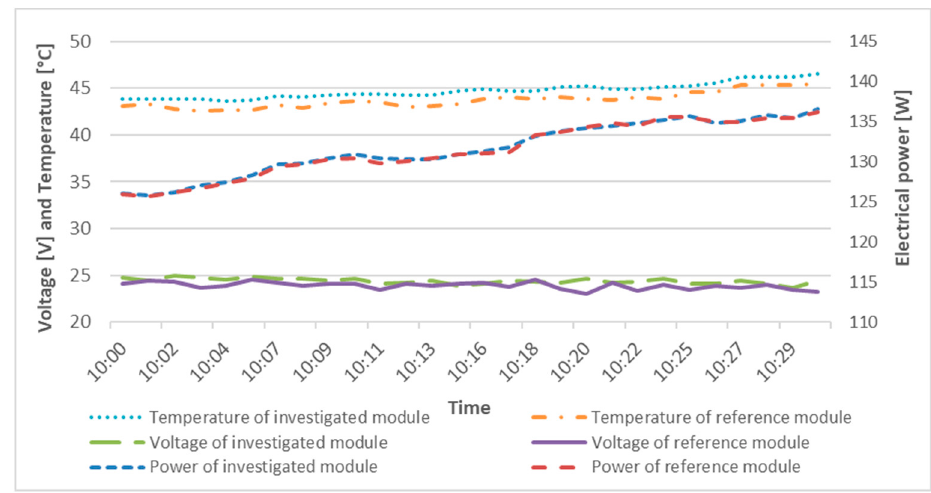
Figure 15. Current of investigated and reference modules during the maximal power test.